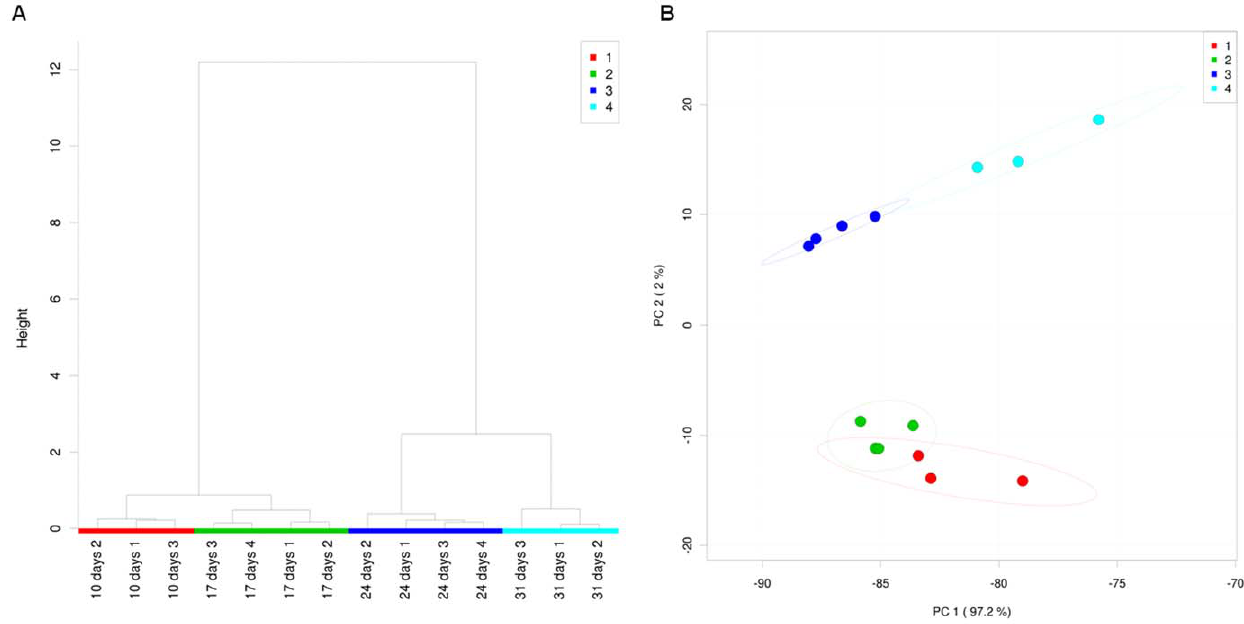
Figure 1. Multivariate analysis of the root exudates analyzed by GC-MS. (A) Cluster analysis (Ward method) based on the 107 compounds detected in root exudates collected at 7–10d, 14–17d, 21–24d, and 28–31d. (B) Principal Component Analysis (PCA) of the 107 root exudate compounds from samples collected at 7–10d, 14–17d, 21–24d, and 28–31d. Dashed ellipses indicate the 95% confidence region of each time point. Red: 7–10 days; Green: 14–17 days; Blue: 21–24 days; Aqua: 28–31 days. 1: 7–10d; 2: 14–17d; 3: 21–24d; 4: 28–31d.